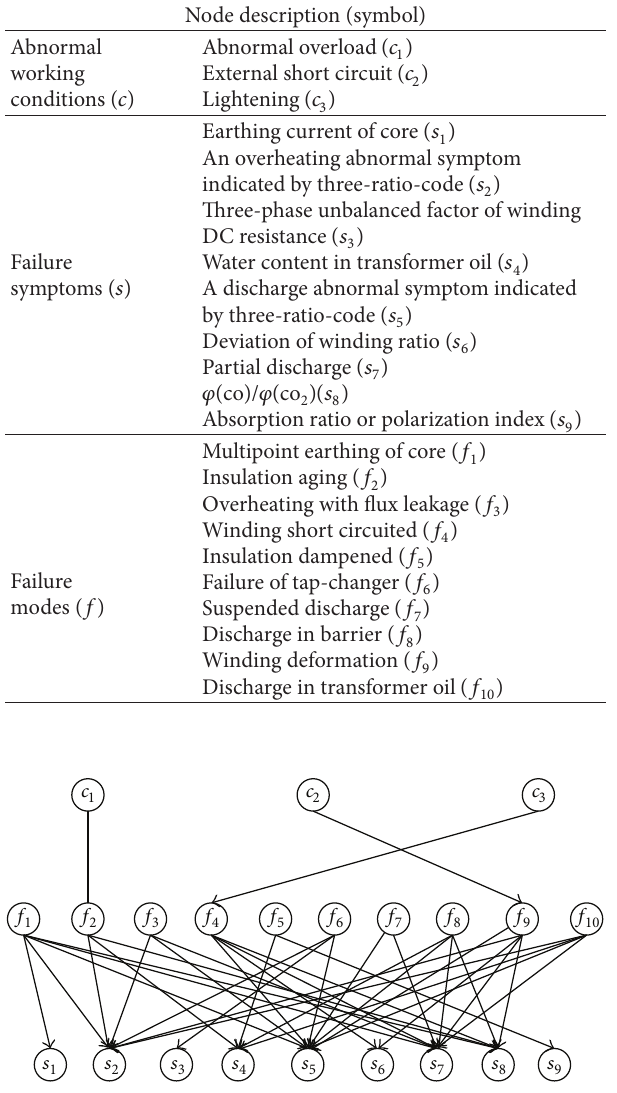
Table 1: Node description in Figure 4 [15].